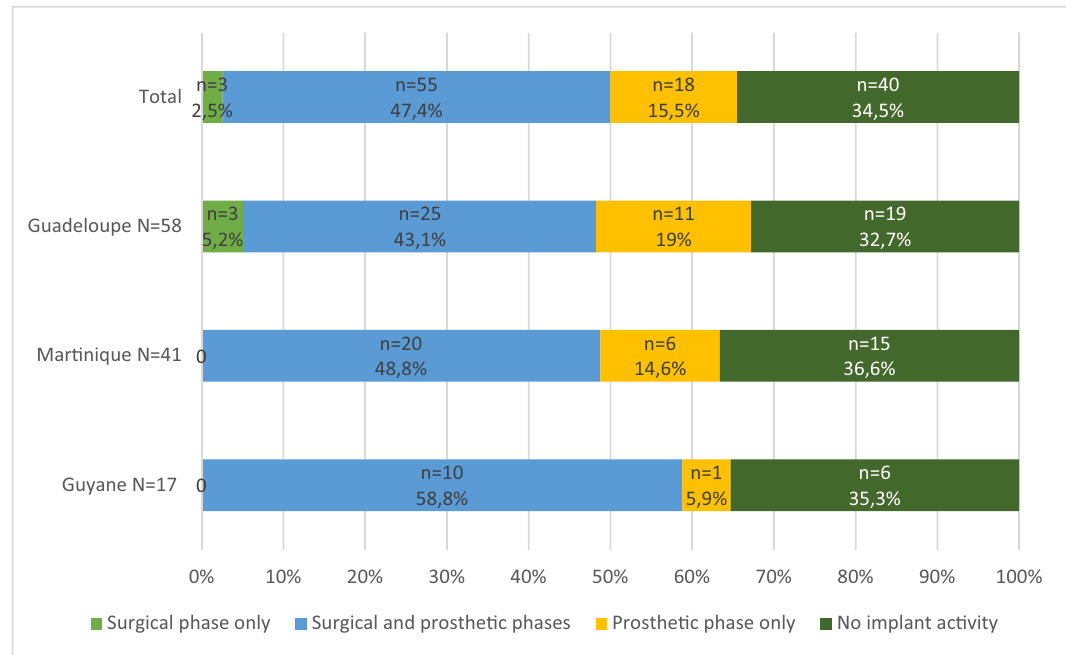
Fig. 1. Dental implant practices of dentists of Guadeloupe, Martinique and French Guyana N =